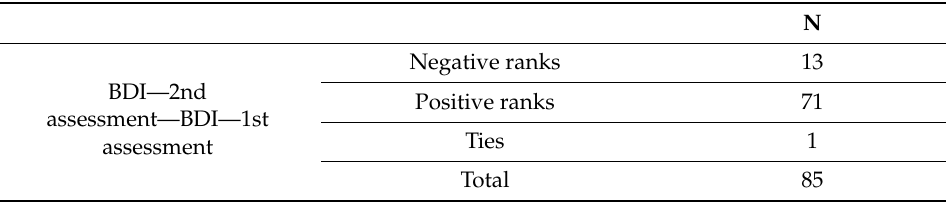
Table 9. Ranks of